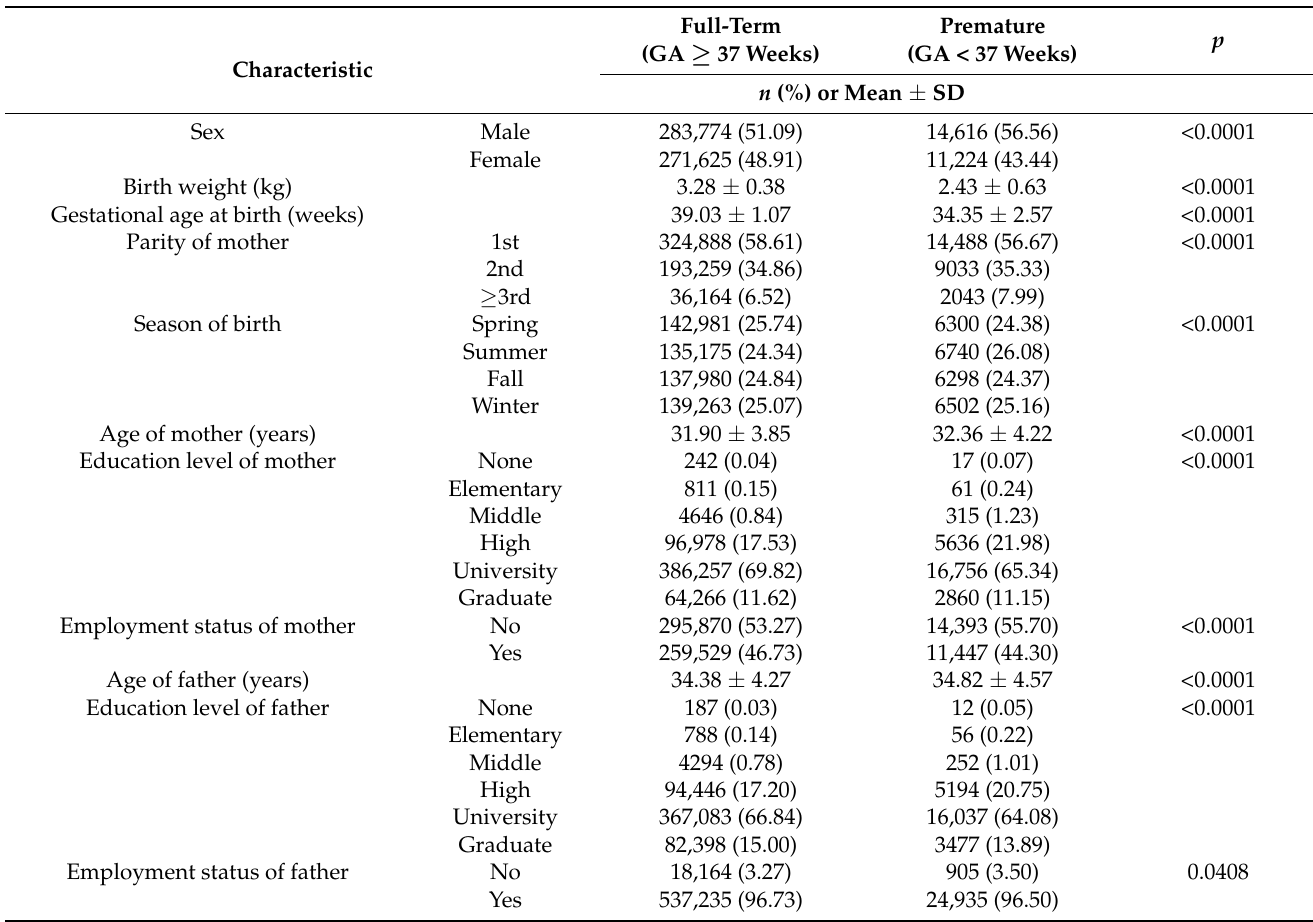
Table 1. Baseline characteristics of full-term and premature babies.